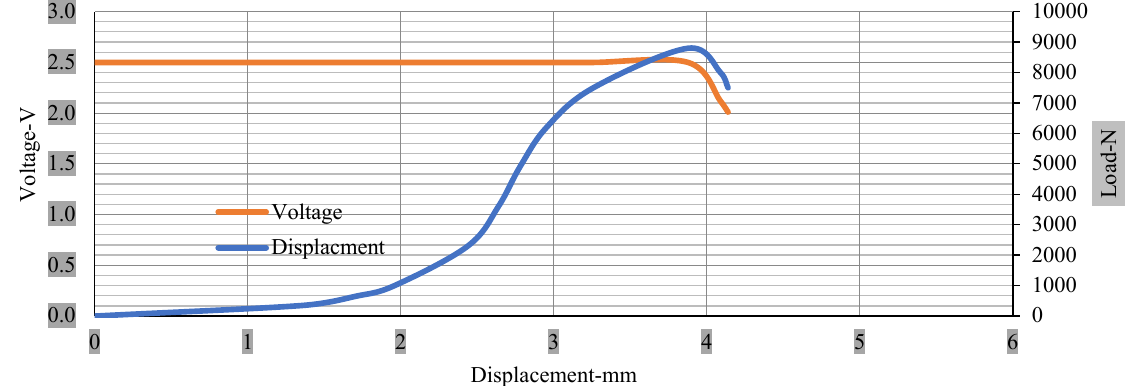
Figure 10. Load and voltage vs. displacement 12 mm punch less than 10% soc.